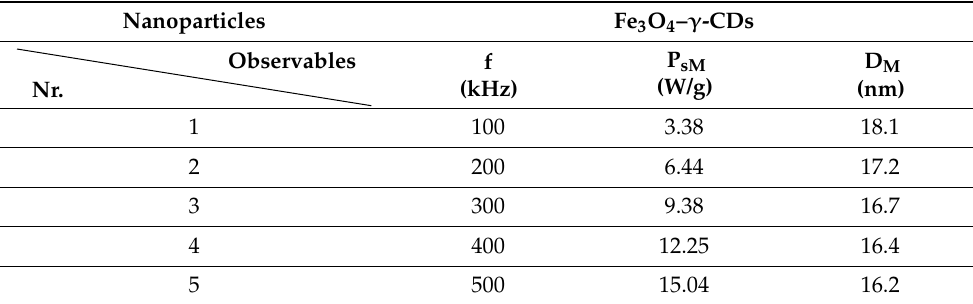
Table 3. The values of P sM and D M at different frequencies for dispersed Fe 3 O 4 – γ -CDs bionanoparticles. H = 10 kA/m; 2d = 3.2 nm.